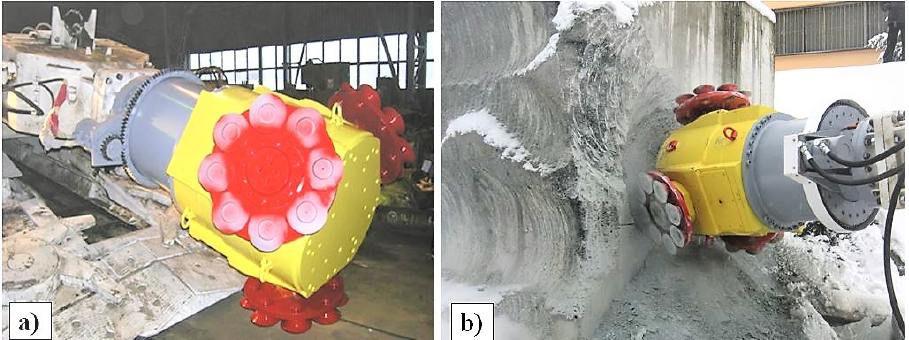
Figure 22. The view of the new mining head solution ( a ) mounted on the KR150 roadheader and ready to tests, ( b ) during one of the conducted mining tests [30,31].